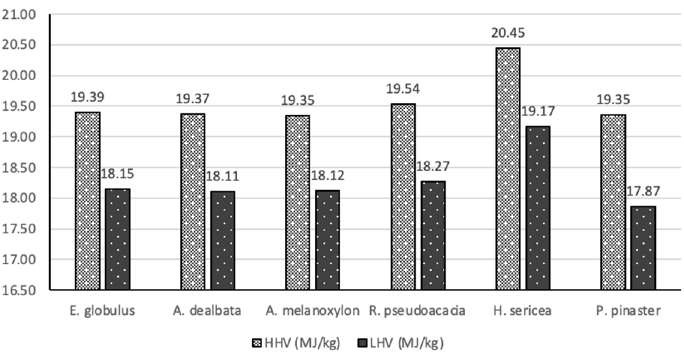
Figure 5. Higher heating value (HHV) and lower heating value (LHV)